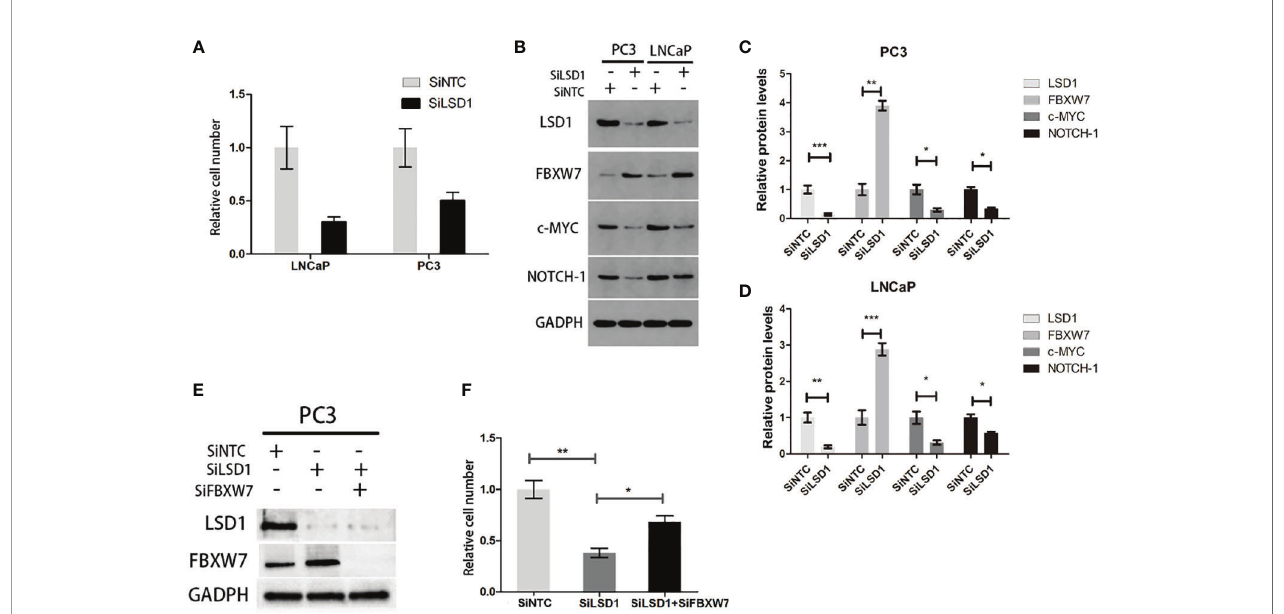
FIGURE 3 | LSD1 promotes prostate cancer cell survival by destabilizing FBXW7 at post-translational level. (A) The relative cell number of LNCaP and PC3 cell lines was detected by cell counter after transfected with SiNTC or SiLSD1. (B) Representative bands of Western blot analysis for the expression of LSD1, FBXW7, c-MYC, and NOTCH-1 in indicated groups. (C, D) Relative expression level of each protein in (B) (SiNTC vs . SiLSD1). (E) Western Blot analysis for the protein expression of LSD1 and FBXW7 in rescue assay. (F) Relative cell number of indicated groups in rescue assay. Values are expressed as the mean ± SEM.*P < 0.05, **P<0.01, ***P<0.001, relative to the SiNTC group, n = 3. Protein levels were normalized by